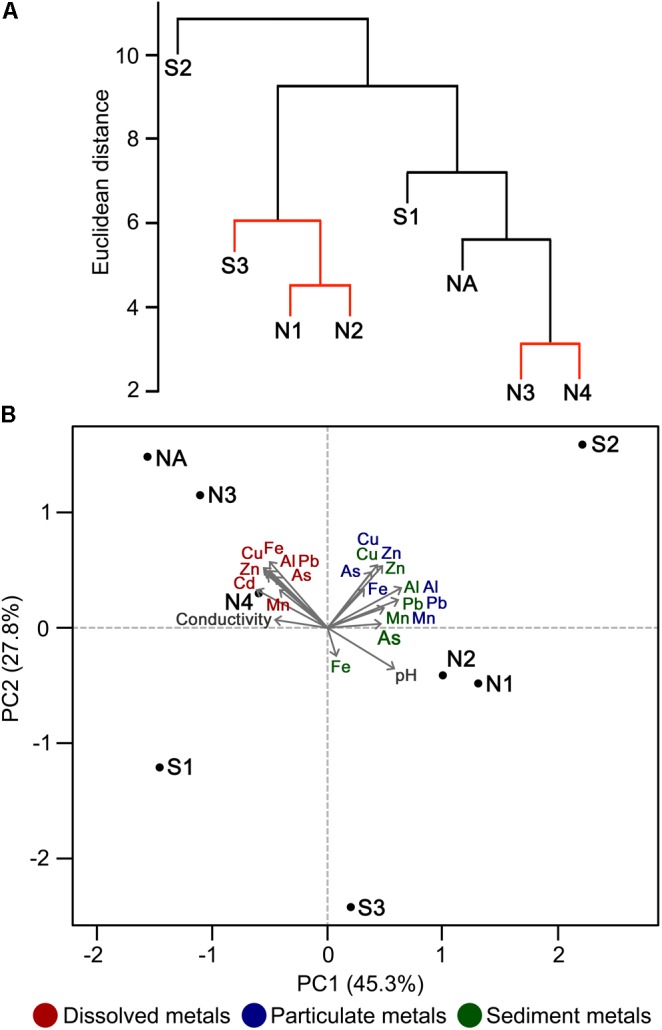
Discrimination of sites on the basis of physicochemical parameters. Hierarchical cluster analysis (A) and PCA ordination plot (B) illustrating the discrimination between sample sites according to environmental properties and their correlation with each environmental factor analyzed. In (A), sites with non-significant clustering (p < 0.05) as determined by SIMPROF are indicated with red lines.